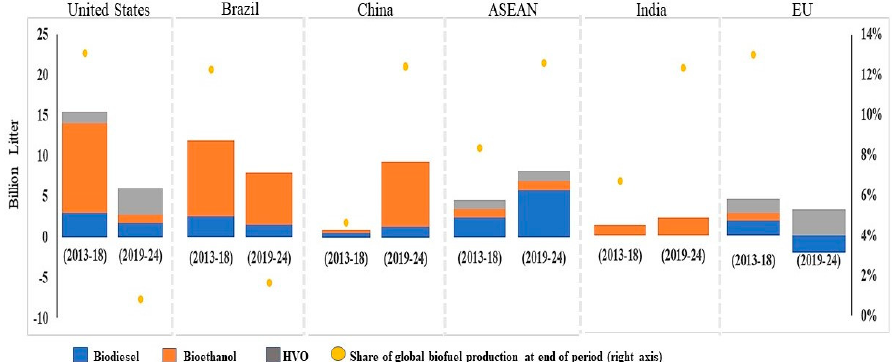
Figure 1. Biofuel production growth worldwide. Hydrotreated Vegetable Oil (HVO). The Association of Southeast Asian Nations (ASEAN).